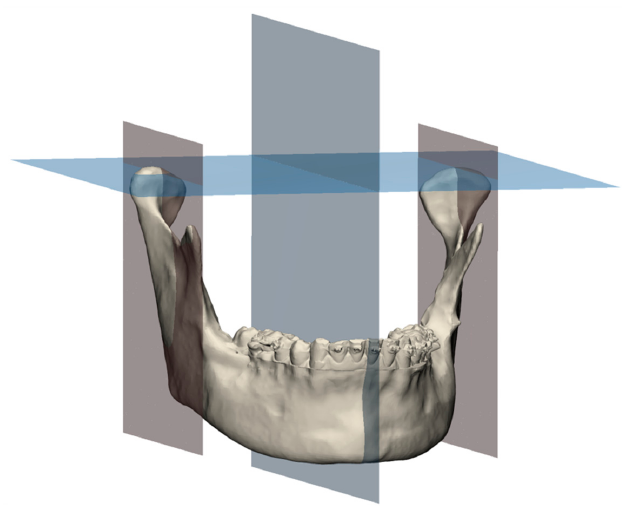
Figure 3. An example of the assigned Frankfurt horizontal plane and matching midsagittal plane (blue). The midsagittal plane was used to create two parallel mid-condylar planes (red), which intersected the condyles in their medio-lateral middle point. These mid-condylar planes were used in the JawAnalyser tool to calculate the patient-specific centres of rotation and, thereby, the patient-specific axis of rotation for the mouth opening.